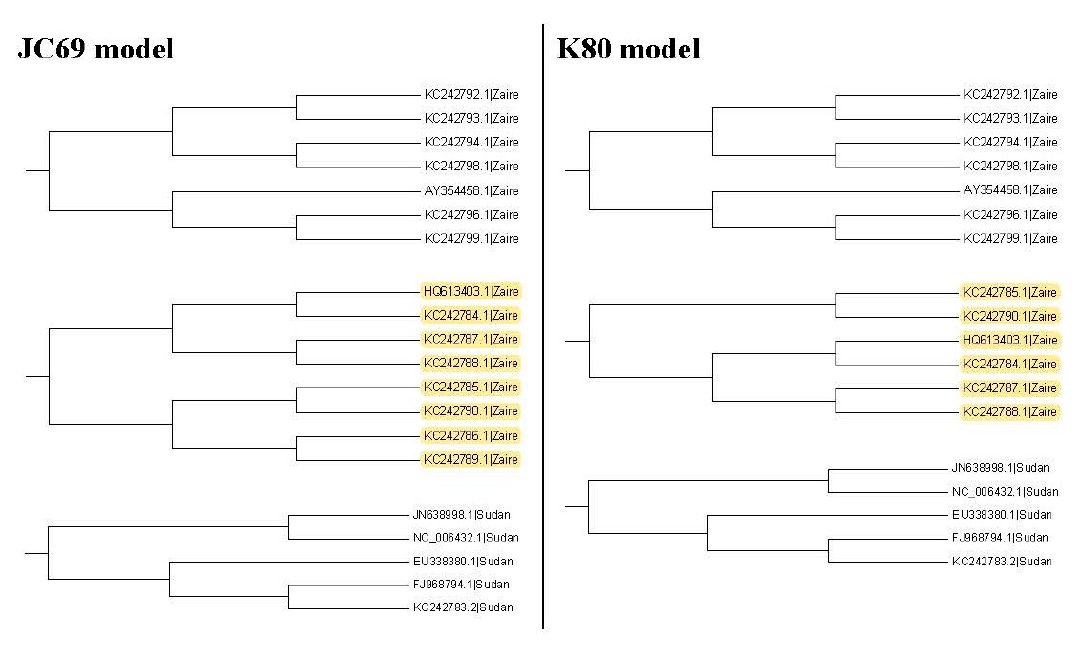
Figure 8. The third clades for the maximum likelihood trees based on the JC69 model and the K80 model. Yellow color: difference. Table 2. The p-values for testing the nucleotide substitution number between sequences in the third clade for the maximum likelihood tree based on the JC69 model.